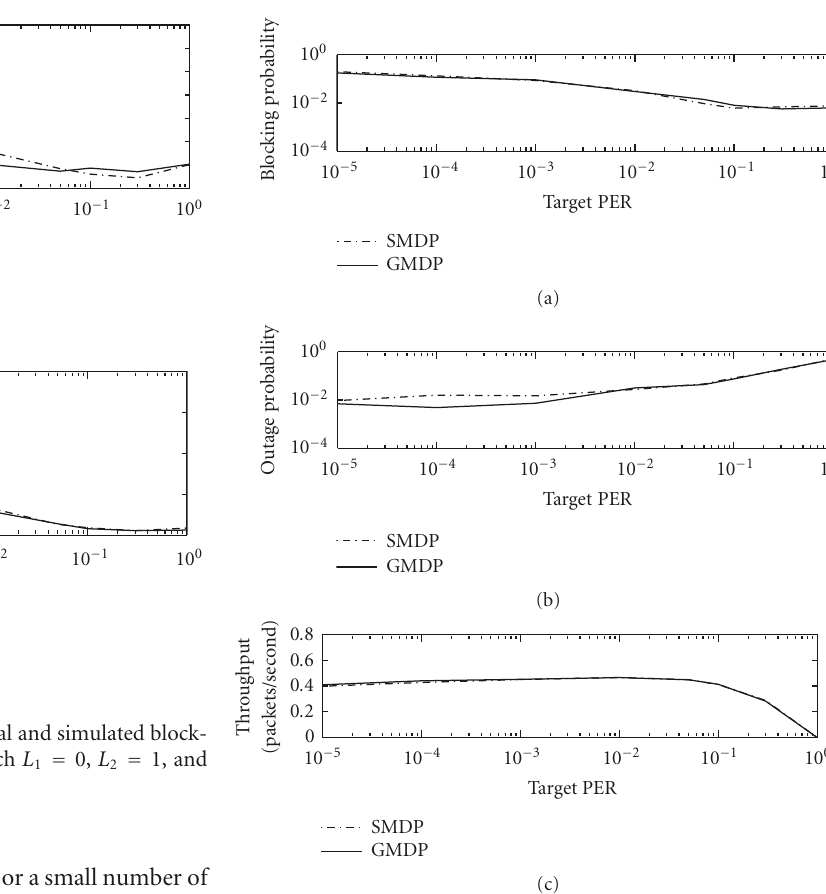
Figure 7: Performance comparison between SMDP and GMDP- based AC policies as a function of ρ = 10 − 4 and ρ 1